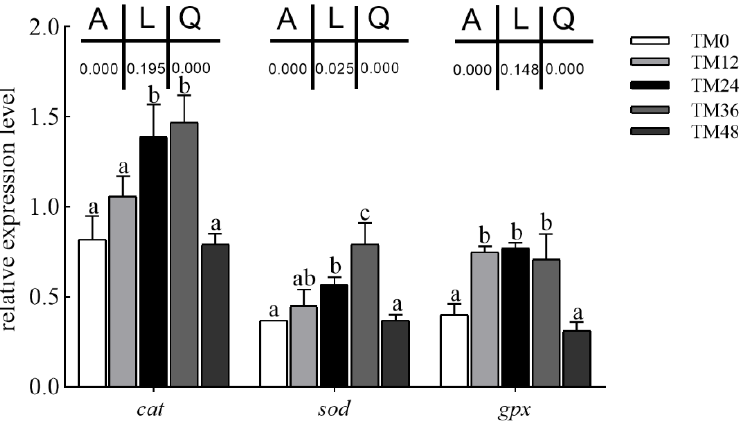
Figure 3. Effects of different levels of TM, instead of FM, on the expression of antioxidant genes in the liver of Micropterus salmoides. Values with different letters represent significant differences in Tukey’s test ( p < 0.05). A = the variance analyzed by one-way ANOVA; L = linear trend analyzed by orthogonal polynomial contrasts; Q = quadratic trend analyzed by orthogonal polynomial contrasts.